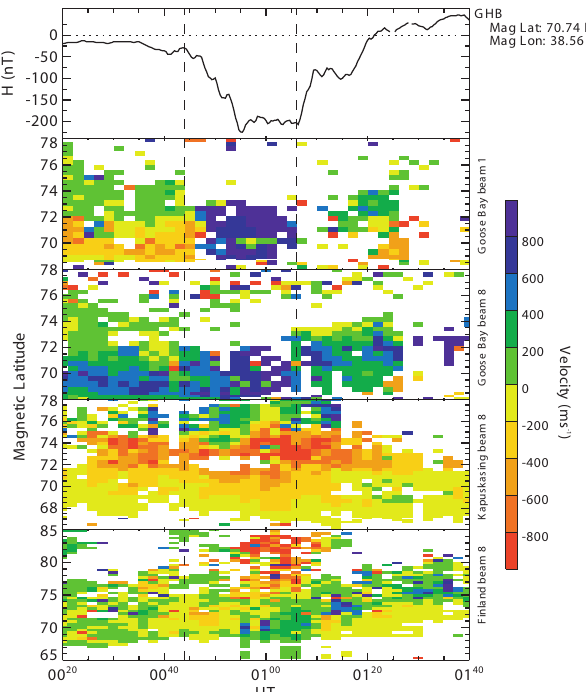
The upper three panels show filtered (20–200s) H - component magnetic field measurements from the low-latitude magnetometer array (green dots in Fig. 1b) for the interval 00:20– 01:40UT on 2 December 1999. Panels three and four simi- larly show geostationary electron fluxes in two energy channels (50–75keV and 75–105keV) from the SOPA instruments on the LANL-97A and 1994–084 spacecraft, while the bottom three panels show geostationary magnetic field measurements from the GOES-8 spacecraft in GSM coordinates. The dashed curves on the GOES-8 plots show the T-89 model magnetic field for Kp=2. The vertical dashed lines are as in Fig. 2.